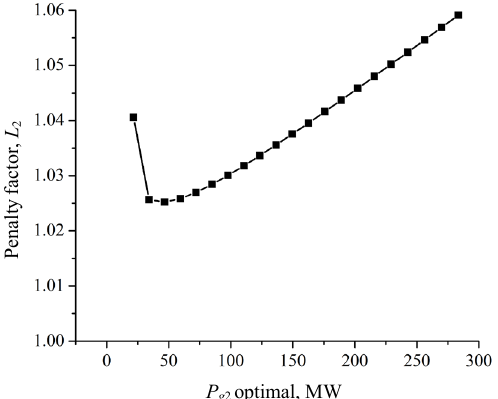
Fig. 9. Penalty factor L 2 vs P g 2